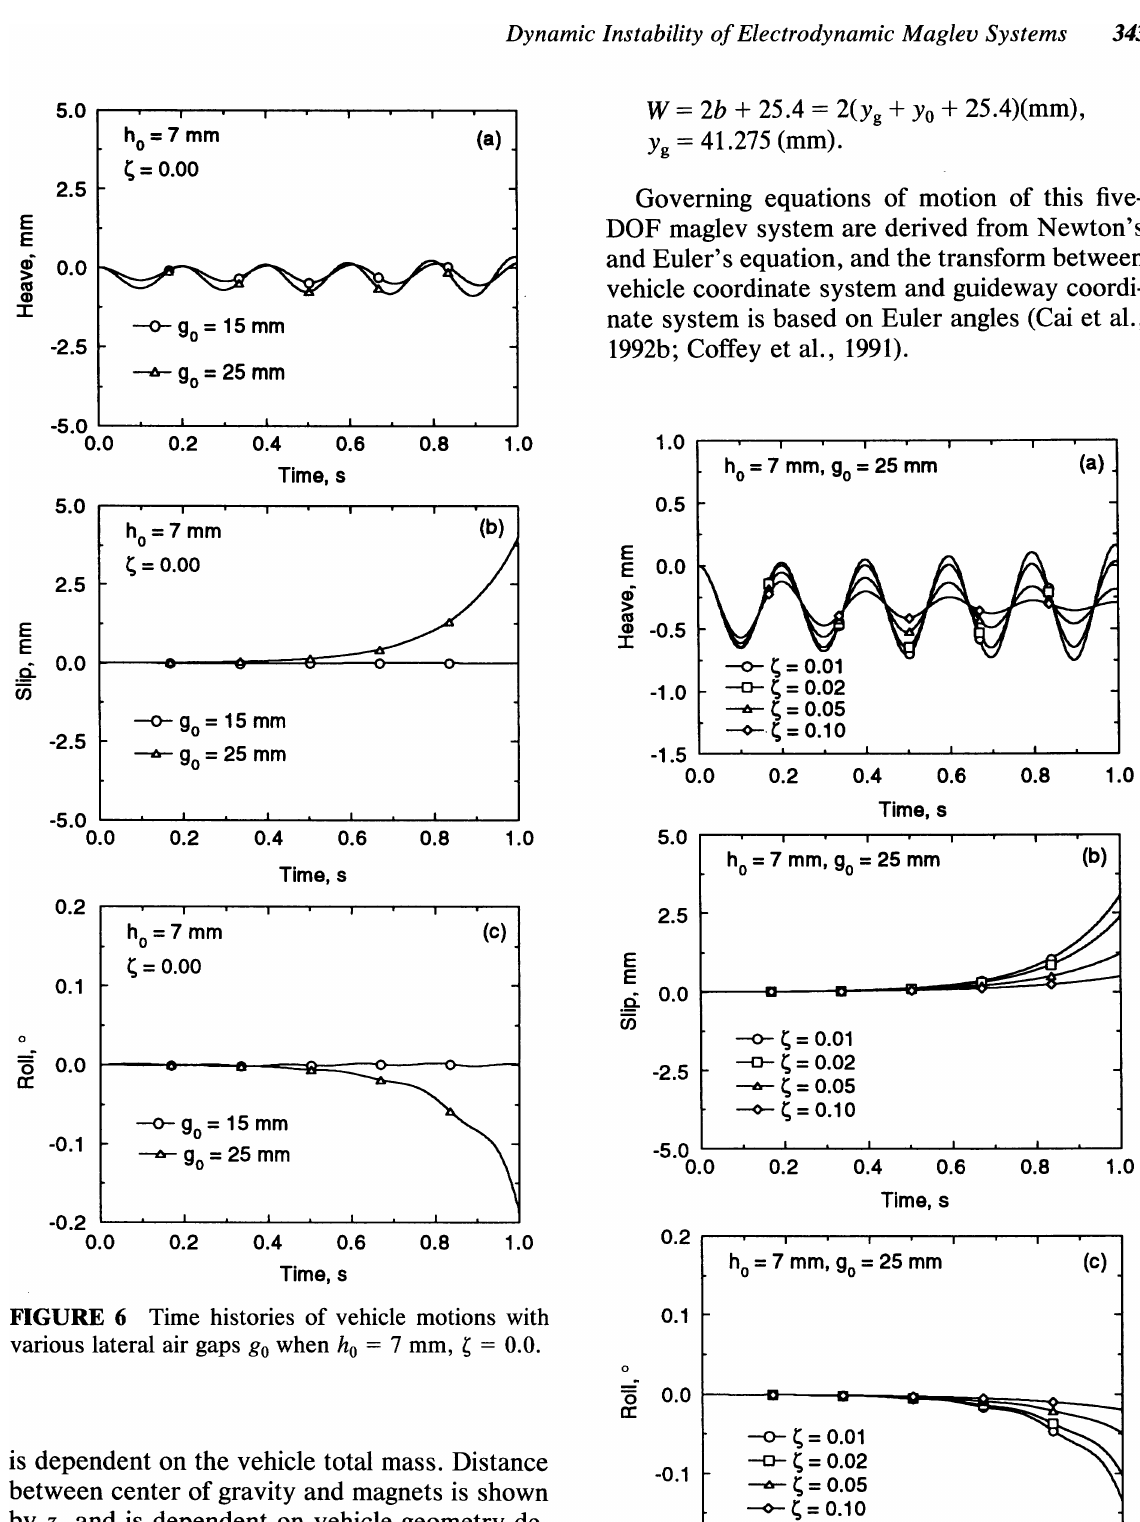
is dependent on the vehicle total mass.